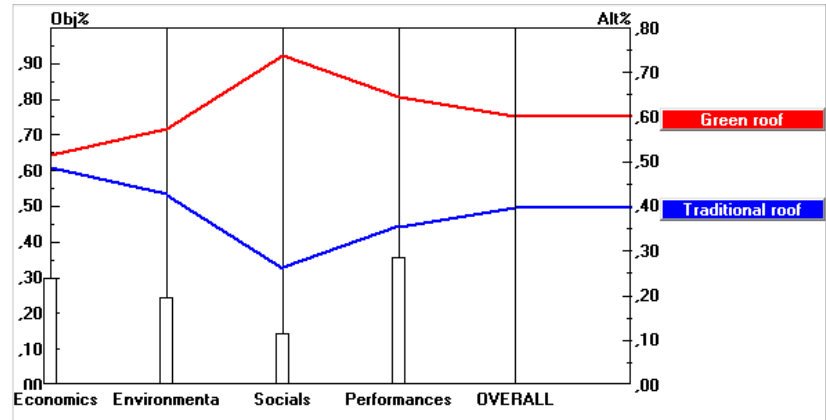
Figure 8. Academics group. Results obtained from the Multi-Criteria Analysis (MCA) reported with respect to the groups of criteria (Obj%; ranges 0.00–0.90) and the scale of the final priority of the two roof alternative solutions (Alt%; ranges